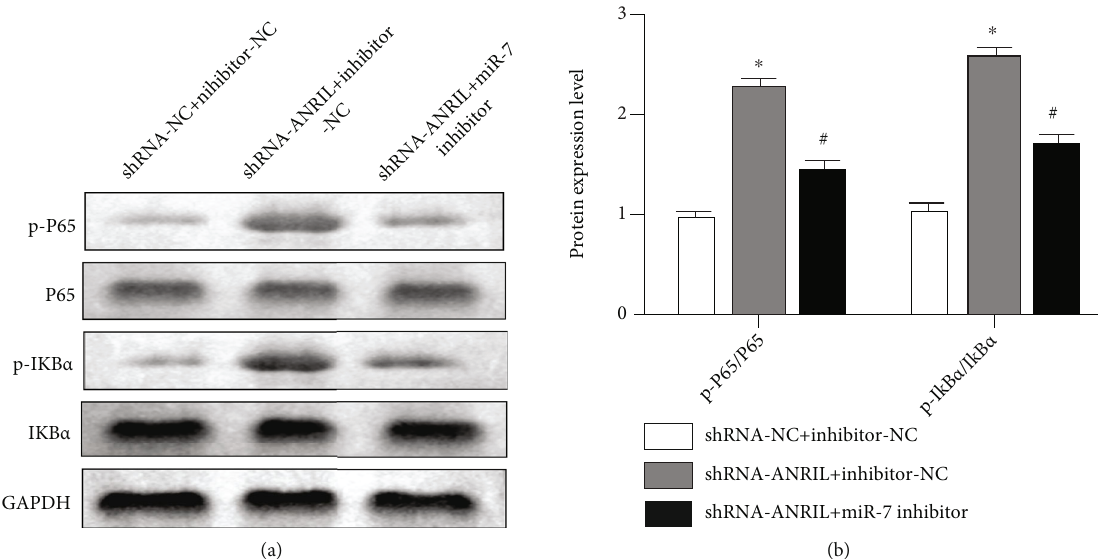
Figure 8: ANRIL activated NF- κ B pathway by inhibiting miR-7. (a) The relative protein expression of p-P65, P65, p-I κ B α , and I κ B α was quanti fi ed by normalizing to GAPDH level. (b) The protein of p-P65, P65, p-I κ B α , and I κ B α was examined by Western blot. ∗ P < 0 : 05